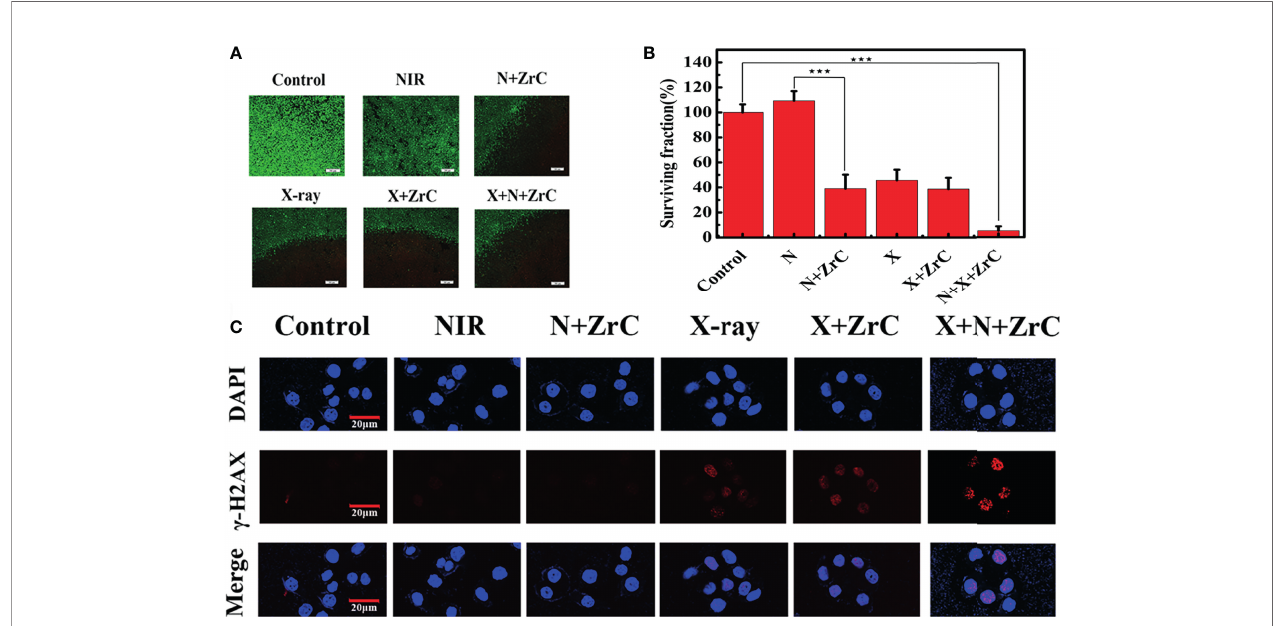
FIGURE 3 | (A, B) live/dead images of 4T1 cells and survival rates analysis after different type of treatment with six groups respectively: Control, NIR, N+ZrC (PT +ZrC NPs), X-ray, X+ZrC (RT+ZrC NPs), X+N+ZrC (RT+PT+ZrC NPs) in concentrations of 0.5 mg mg·mL-1and irradiated with an 808 nm laser 4min with 1.5 W cm- 2, X-ray with 6MV,4Gy. Error bars represent mean ± SD. P values based on Student ’ s t-test: ∗∗∗ p < 0.001. (C) Qualitative representation of DNA fragmentation with different treatment (scale bar: 20 m